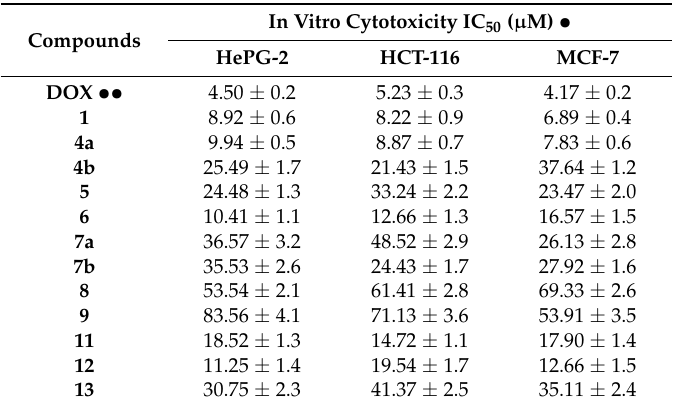
Table 4. Cytotoxic activity of derivatives ( µ M) against human tumor